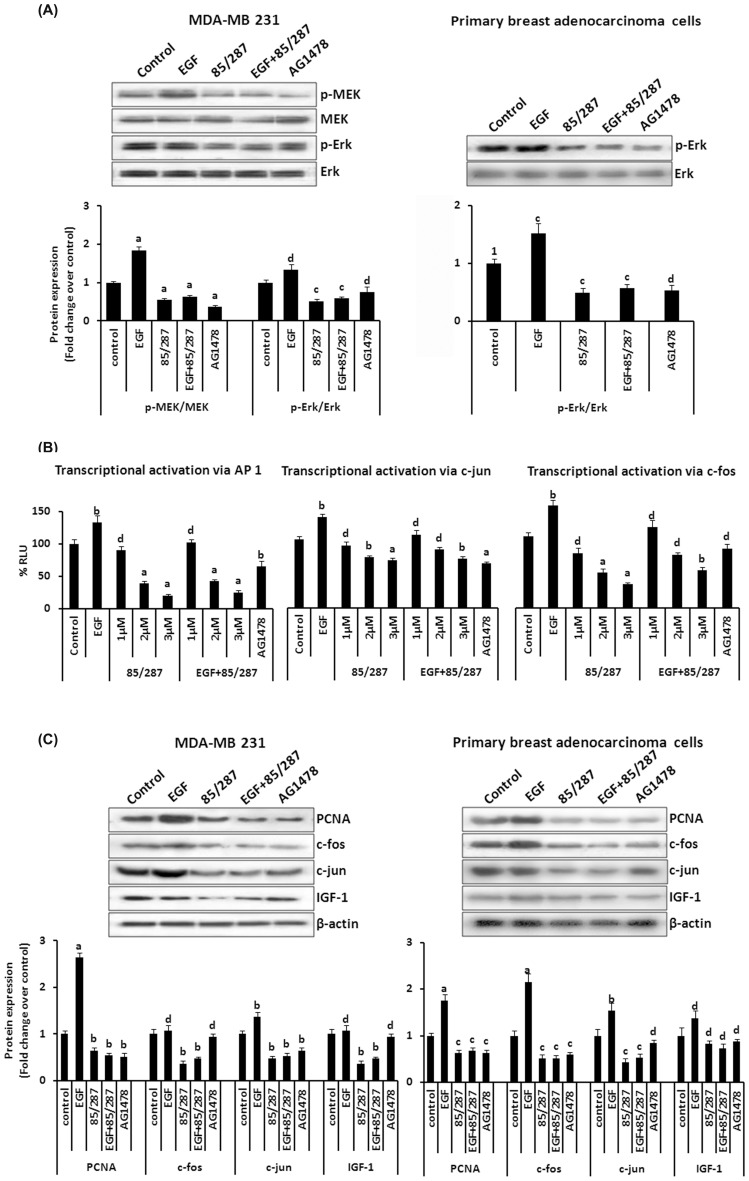
CDRI-85/287 interferes with MEK/Erk activation to inhibit downstream signaling.(A) Western blot analysis to see the expression of p-MEK, MEK, p-Erk and Erk. MDA-MB 231 (left panel) and primary breast cancer cells (right panel) were treated with the indicated concentrations of CDRI-85/287 for 24h and 30 µg of whole cell lysate in each lane was probed for the expression of different proteins using specific antibodies. Representative blots are shown in the upper panel and densitometric quantitation of protein expression levels are shown as fold changes in the lower panel. Results are expressed as mean ± SEM, n = 3. p values are a-p<0.001, b<0.01, c-p<0.05 and d-p>0.05 vs. control. (B) Transcriptional activation of the AP-1 promoter complex in transiently transfected MDA-MB 231 cells in response to CDRI-85/287 alone or in the presence of 100 ng/ml EGF. MDA-MB 231 cells were transfected with pAP1-Luc or p-c-fos-Luc or p-c-jun-Luc reporter plasmids and incubated with various concentrations of compound for 24h. pRL-luc plasmid was used as internal control. Results are described as % of normalized relative luciferase unit (RLU). Results are expressed as mean ± SEM, n = 3. p values are a-p<0.001, b-p<0.01, c-p<0.05 and d-p>0.05 vs. control and e-p<0.001, f-p<0.01, g-p<0.05 and h-p>0.05 vs. EGF. (C) Effect of compound on AP-1 dependent proliferation markers. MDA-MB 231 (left panel) and primary breast cancer cells (right panel) were treated with the indicated concentrations of compound for 48h. 30 µg of whole cell lysate in each lane was probed for the expression of different proteins using specific antibodies. Representative blots are shown in the upper panel and densitometric quantitation of protein expression levels are shown as fold changes in the lower panel. Results are expressed as mean ± SEM, n = 3. p values are a-p<0.001, b<0.01, c-p<0.05 and d-p>0.05 vs. control.